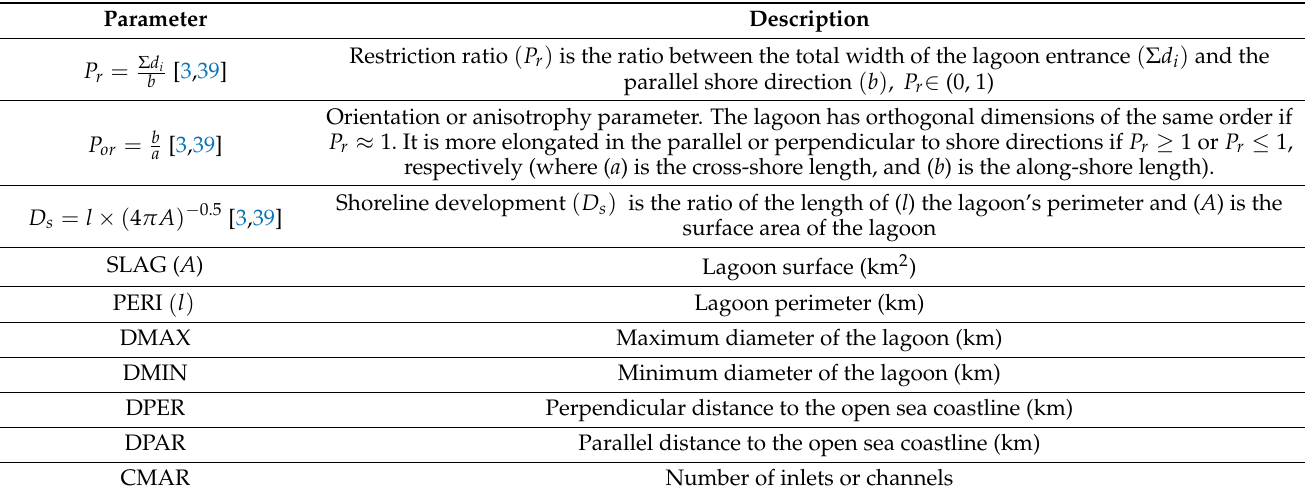
Table 2. Morphometric lagoon